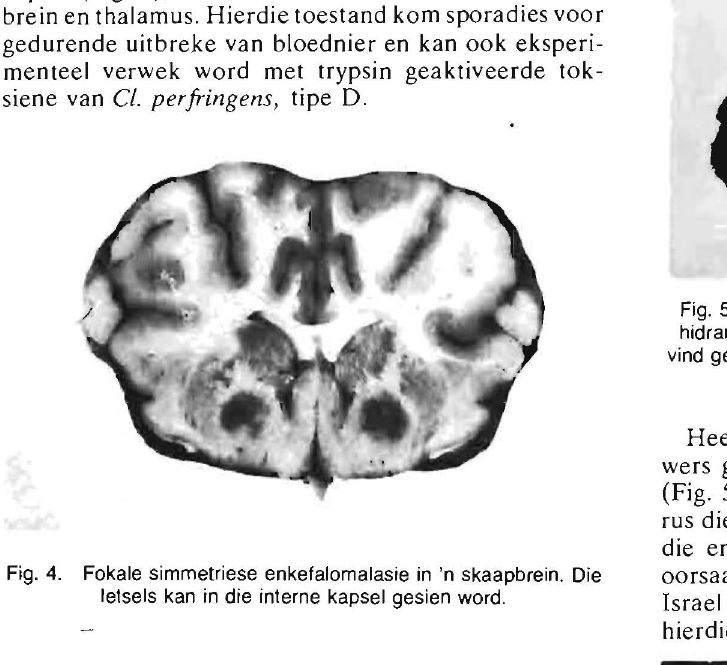
Fig. 4. Fokale simmetriese enkefalomalasie in 'n skaapbrein. Die letsels kan in die interne kapsel gesien word. Hartwater'9